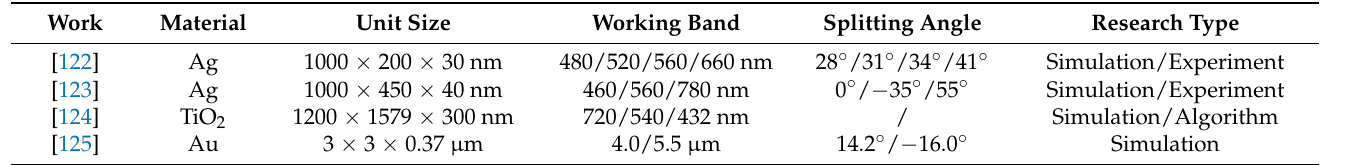
Table 6. Parameters of wavelength metasurface beam splitters described in this